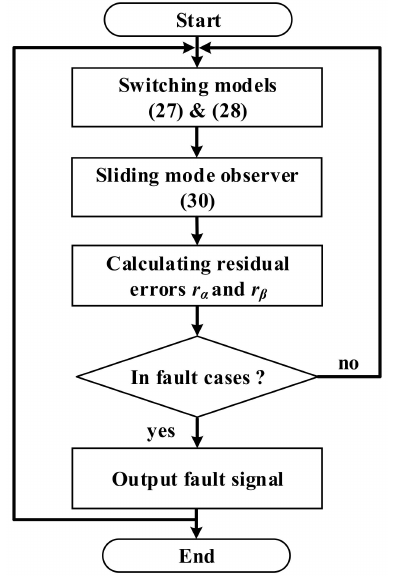
Figure 7. Flowchart of the fault diagnostic